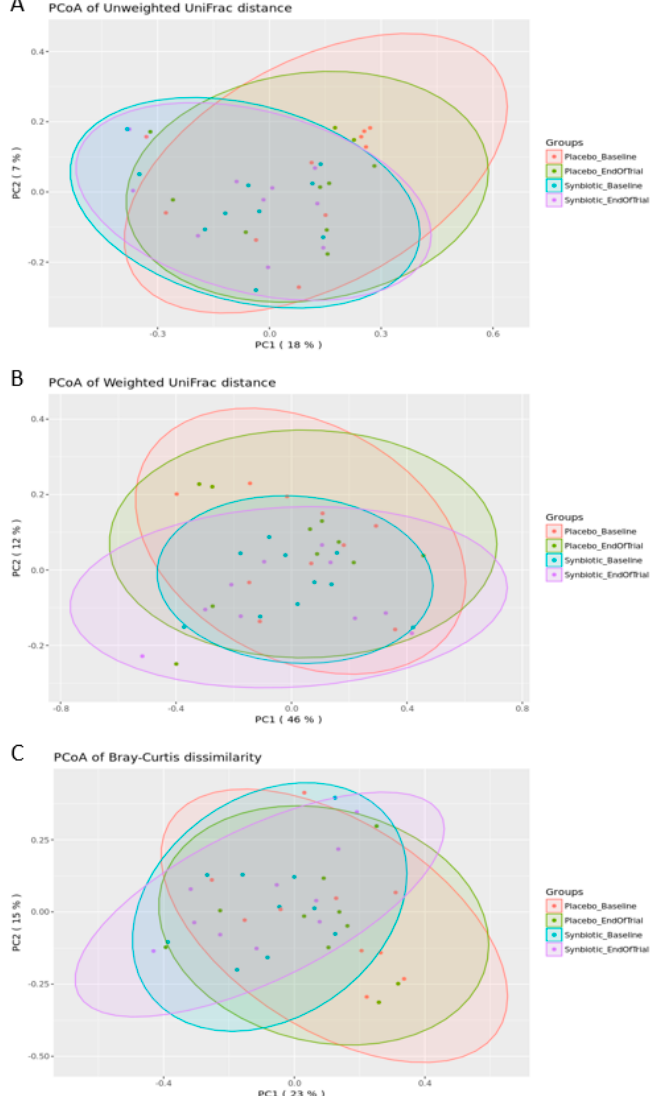
Figure 4. Principal Coordinates Analysis (PCoA) of unweighted UniFrac ( A ), weighted UniFrac ( B ) and Bray–Curtis dissimilarity data ( C ). The scatter plots show principal coordinate 1 (PC1) vs. principal coordinate 2 (PC2) with percentages of variation explained by the components indicated. The points are colored by the treatment group and time